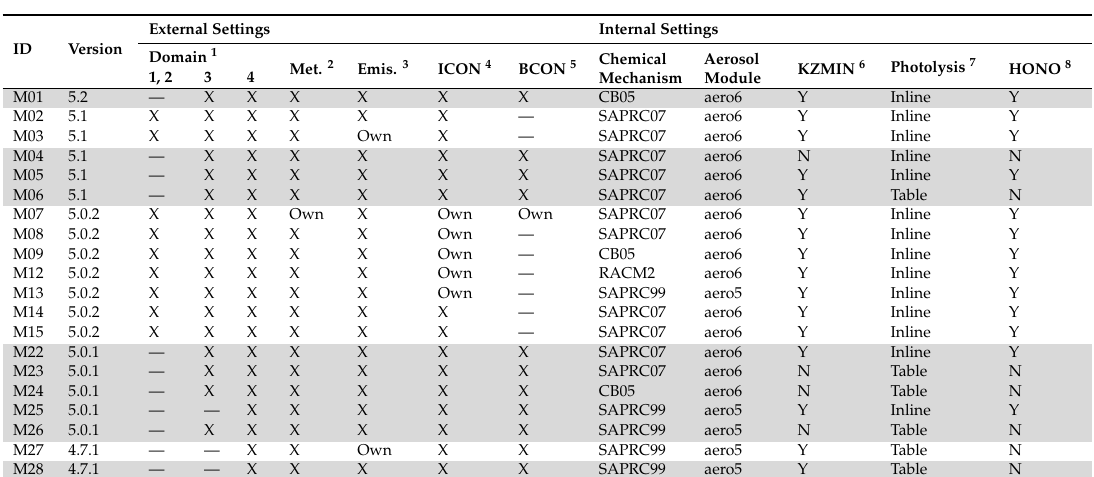
Table 1. CMAQ model configurations for this study of the first-phase of J-STREAM.